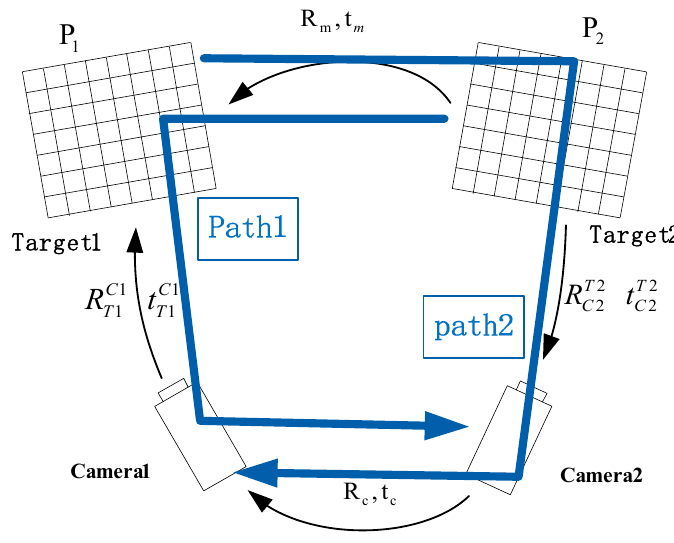
Figure 2. Reprojection error optimization schematic.